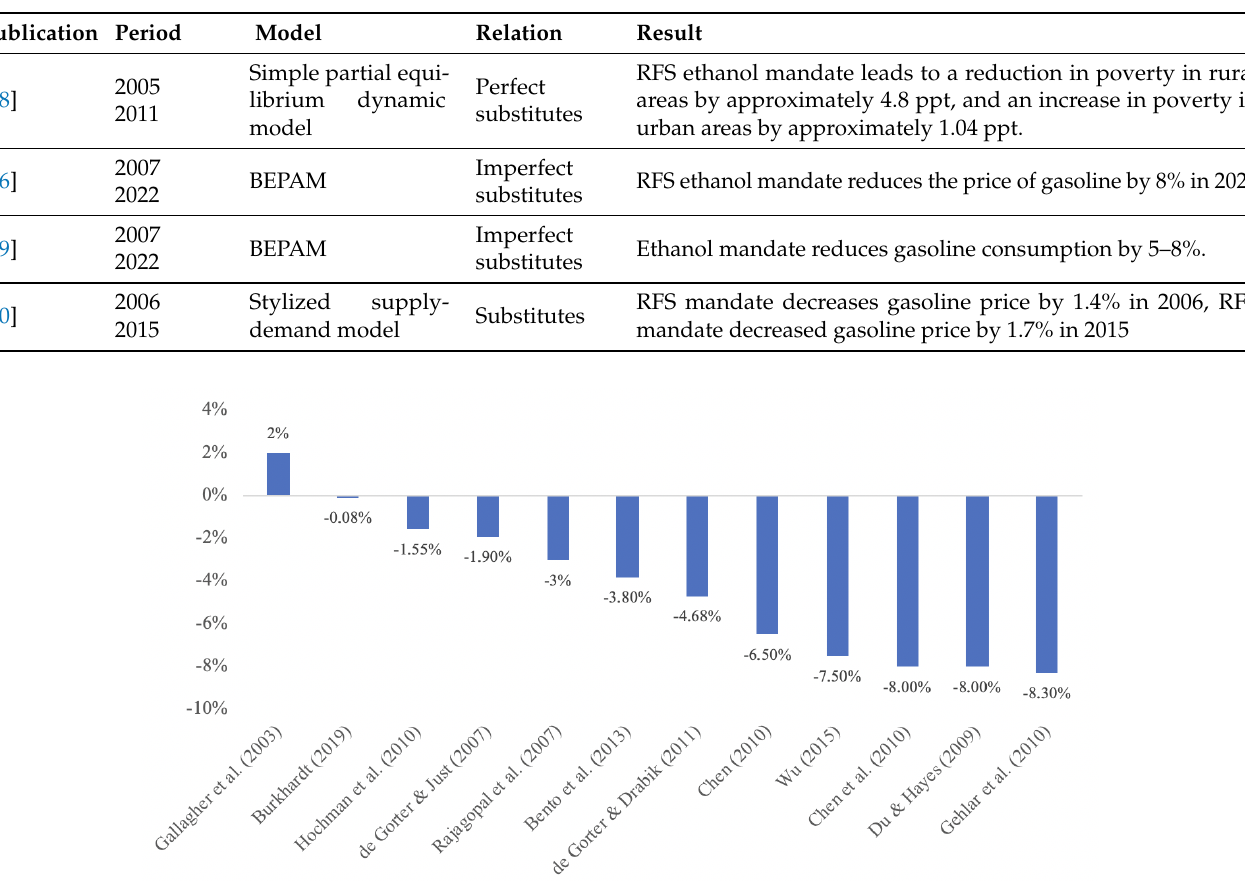
Table 2. This table summarizes publications in the analysis of [12] concerned with the impact of ethanol on fuel price or welfare. The first column references the publication, and the second column the inspected time period. The third column reports on the model used. The Relation column suggests whether ethanol and gasoline are considered to be perfect or imperfect substitutes, and Results summarizes the respective study.